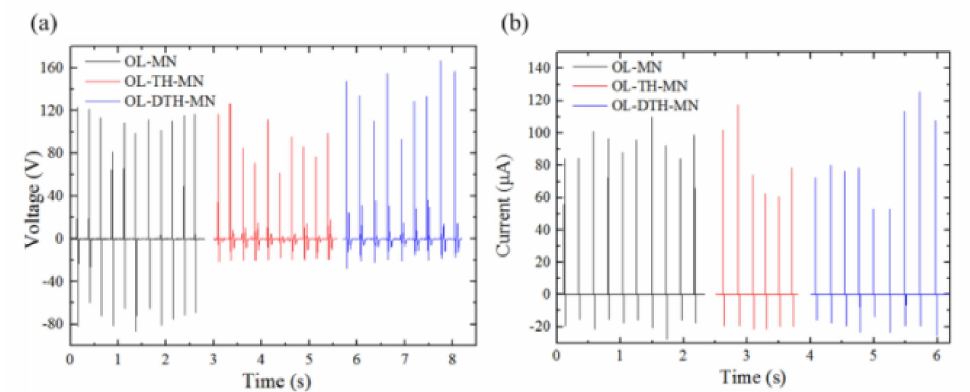
Figure 31. The measured output performance of open-circuit voltage and short-circuit current of overlapped two-height microneedle array: ( a ) Voltage and ( b ) current was measured of the OL-MN, OL-TH-MN, and OL-DTH-MN during real-time hand